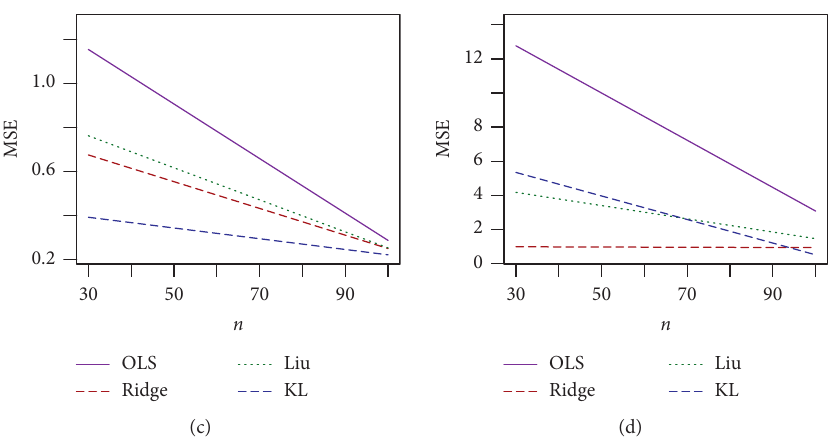
Figure 4: Estimated MSEs for sigma � 1, p � 3, and different values of rho and sample size. (a) p � 3, sigma � 1, d � 0.5, and rho � 0.70. (b) p � 3, sigma � 1, d � 0.5, and rho � 0.80. (c) p � 3, sigma � 1, d � 0.5, and rho � 0.90. (d) p � 3, sigma � 1, d � 0.5, and rho � 0.99.